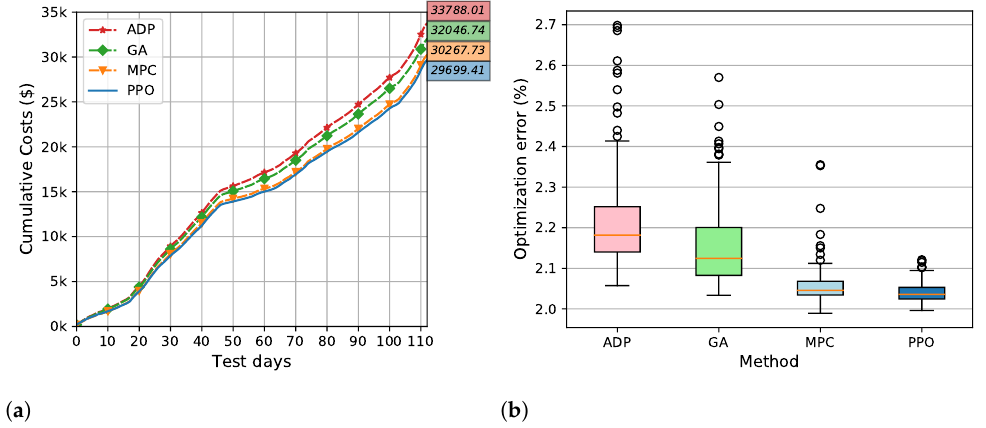
Figure 3. Comparison of MPC, ADP, GA, and the proposed approach on 113 testing days. ( a ) Cumu- lative operating costs; ( b ) Optimization